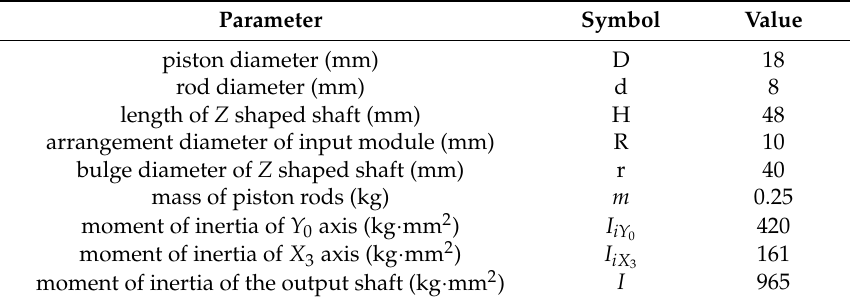
Table 1. The structural parameters of the wobble plate joint in the simulation.